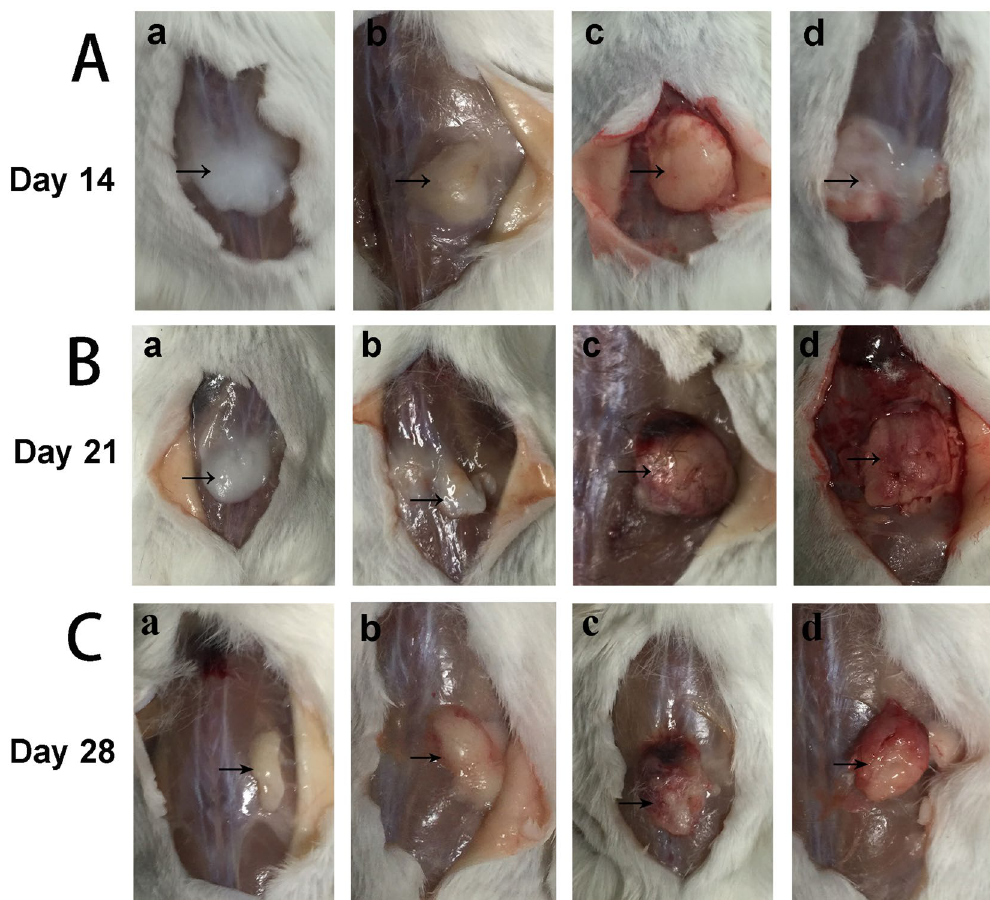
Figure 6. Hydrogel degradation under subcutaneous layer for 2 weeks (Line A), 3 weeks (Line B) and 4 weeks (Line C). lowercase letter a, b, c, d represent control group, V, B and VB group, respectively. Formation of bone- like hard tissue can be observed in B and VB